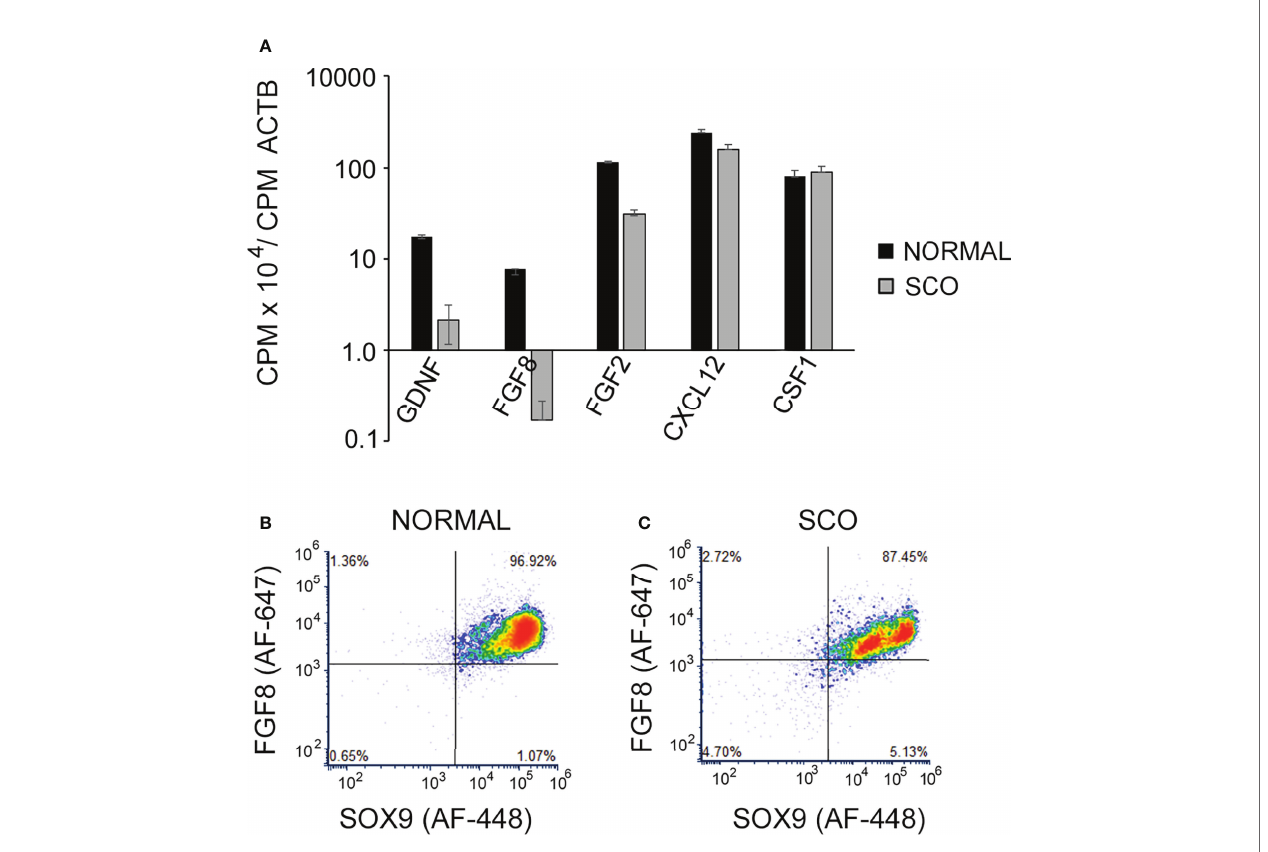
FIGURE 6 | The abundance of GDNF, FGF8, GF2, CXCL12 and CSF1 mRNAs in the transcriptomes of human normal and SCO testes. (A) CPMs of each transcript in each of the transcriptomes of 4 normal and 7 SCO testes were normalized for CPM of b actin. Normalized data (mean + SEM) con fi rm that GDNF mRNA levels are markedly lower in SCO testes and reveal that expression of both FGF8 and FGF2 mRNA are also signi fi cantly reduced in SCO testes. (B, C) Fluorescence activated cell sorting was used to determine if human Sertoli cells express FGF8 and if this expression is signi fi cantly reduced in SCO testes. Single cell suspensions were prepared from normal and SCO testes, cells were immunolabeled for FGF8 and the human Sertoli cell-speci fi c marker SOX9 (23) and FGF8 and SOX9 expression analyzed. Results, which are representative of 3 independent experiments, present FGF8 and Sox 9 expression by individual cells. This analysis demonstrates that normal human testes contain a single population of FGF8-expressing Sertoli cells. SCO testes contain 2 populations, and cells in the larger population contain less FGF8 than Sertoli cells in normal testes. Results are from: